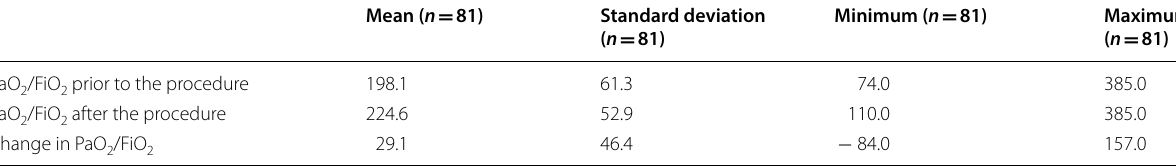
Mean ( n 81) Standard deviation =